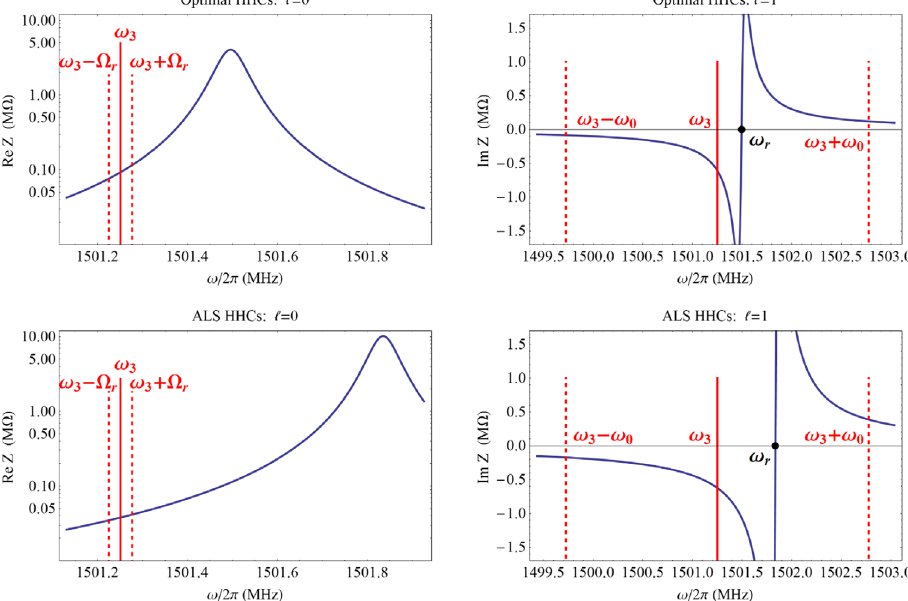
FIG. 5. Comparingtheinstabilitydriversforthe l ¼ 0 (left)and l ¼ 1 (right)mode instability.Forthe l ¼ 0 modeitistherealpart ofthe HHCfundamentalmodeimpedancetoberelevantandtheinstabilitygrowthratedependsonthedifferencebetweenthevaluesofRe Z onthe upper ω 3 þ Ω r and lower ω 3 − Ω r sidebands, where Ω r is the (real) mode oscillation frequency, divided by Ω r or, effectively, the derivative of Re Z at ω ¼ ω 3 . The pictures indicate that the Re Z (positive) slope for the optimum HHCs (top) is larger than that for the ALS HHCs (bottom) and therefore the instability higher. (For better illustration, in the picture Ω r is not to scale.) In contrast, for mode l ¼ 1 , in the regimewheretheasymptoticapproximation(47),(49)applies,itisIm Z toberelevant:thegrowthrateisproportionaltothesquarerootofthe